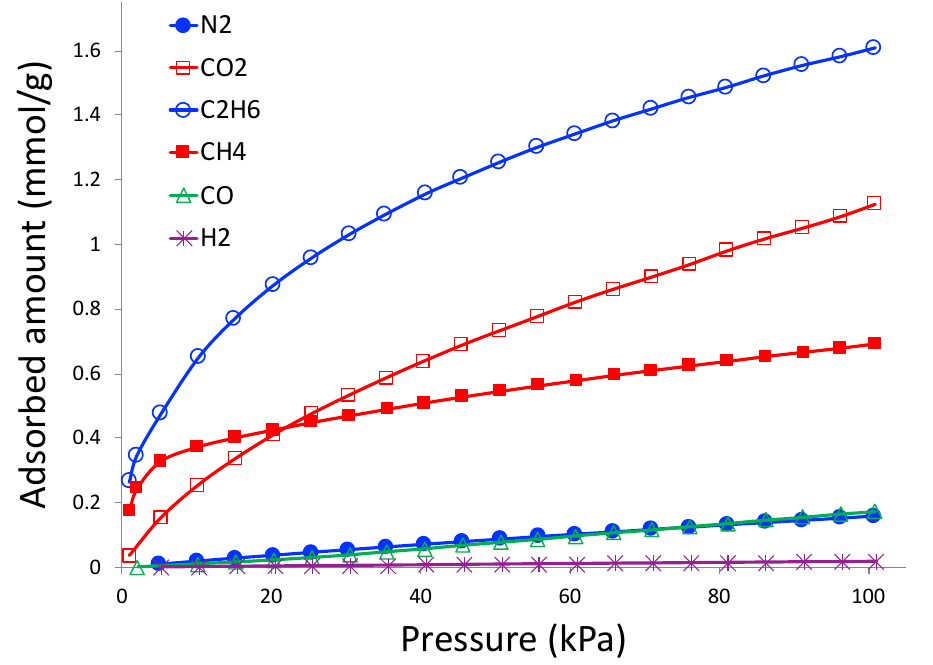
Figure 8. Gas adsorption isotherms on 3D printed porous carbon monolith at 298 K.